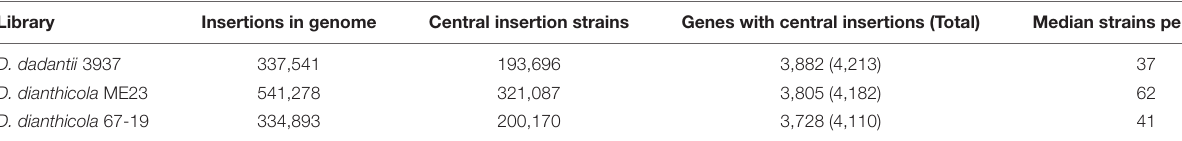
TABLE 1 | Characteristics of the mariner transposon libraries.